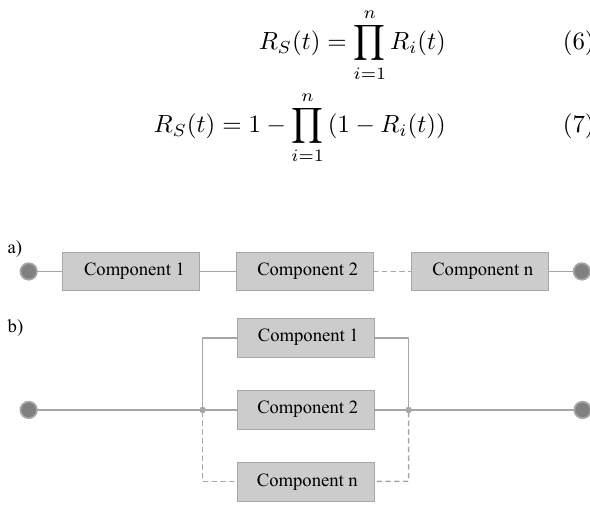
Figure 7: Reliability structure a) serial b)